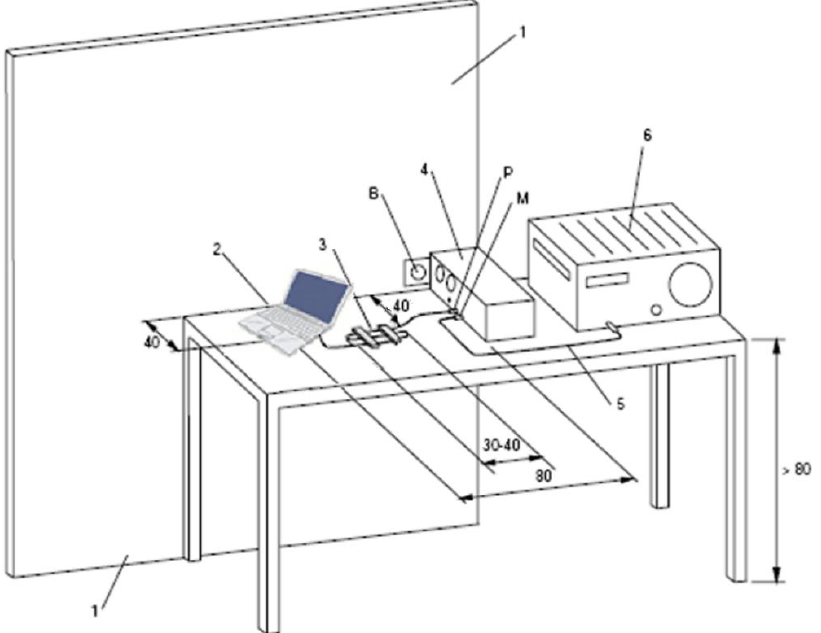
Figure 11. The setup for the conducted emission measurement: 1 — Metallic wall 2 m × 2 m; 2 — EUT (laptop); 3 — Excess power cord (10 m); 4 — LISN; 5 — Coaxial cable; 6 — Measuring receiver; B — Reference ground connection; M — Measuring receiver input; P — Power to EUT [29].